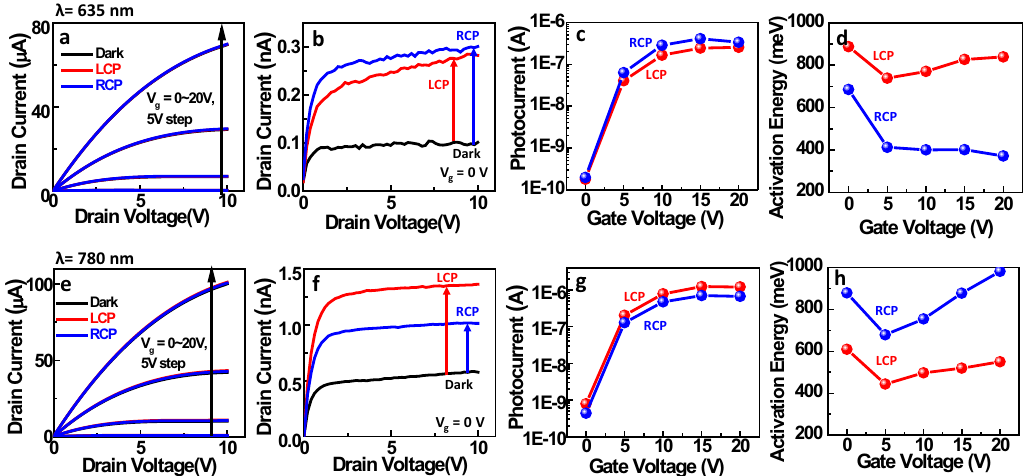
Fig. 2 | Photocurrent and activation energy of the IGZO-chiral gold nano- particlearray.a , e OutputcurveoftheCPL-detectingtransistorunderillumination with635nmand780nmCPL,respectively.ThepowerdensityofLCPandRCPlight is precisely calibrated at 3.7mW/cm 2 , and the active area is 100 μ m × 50 μ m.